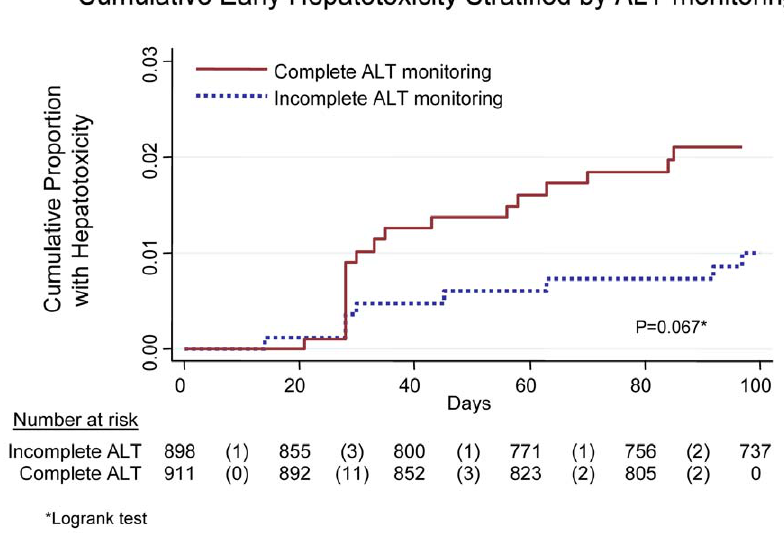
Figure 1. Cumulative early hepatotoxicity stratified by ALT monitoring.